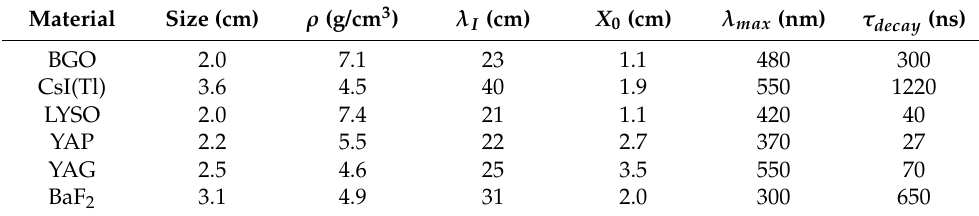
Figure 3. Left panel: image of the CaloCube prototype made of CsI crystals. Central panels: image of a prototype layer with CsI crystals (bottom panel) and a crystal with a VTH2090 PD (top panel). Right panel: image of the last tray, which includes different scintillators. Table 2. Main properties of the tested materials, where ρ is the density of the crystal, λ i and X 0 are the interaction and radiation lengths, respectively, λ max is the wavelength of the scintillation light at the emission maximum, and τ decay is the decay